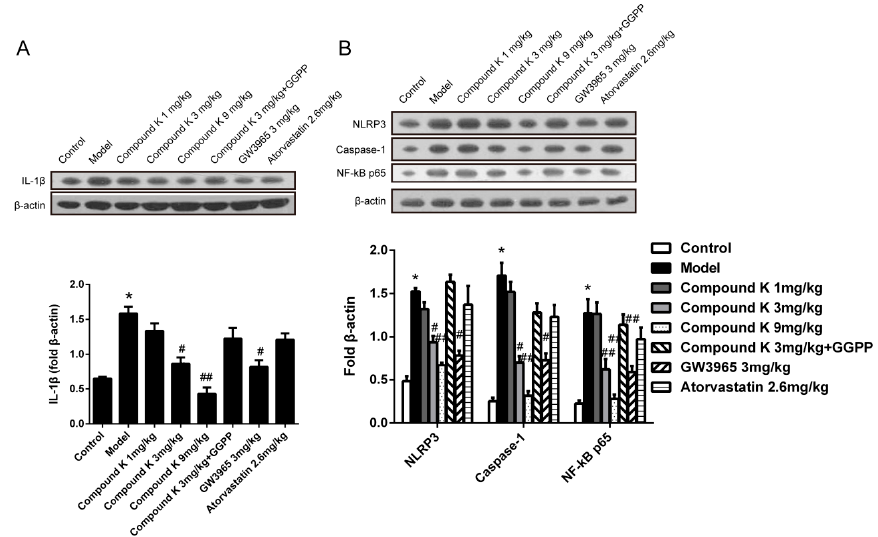
Figure 3. Effects of compound K on inflammasome activity in apoE − / − mice aorta. The level of cleaved-IL-1 β in mice aorta was detected by immunoblotting. Treatments of compound K (3, 9 mg/kg) significantly attenuated the increase of cleaved-IL-1 β ( A ) expression. To investigate the probably mechanism, the levels of NLRP3, caspase-1 and nuclear NF- κ B p65 ( B ) were detected by western blotting, and normalized to β -actin. Data are presented as mean ± SEM ( n = 6) and analysed by ANOVA with Dunnett’s post-hoc analysis. * p < 0.05 vs. control; # p < 0.05 vs. model; ## p < 0.01 vs. model.